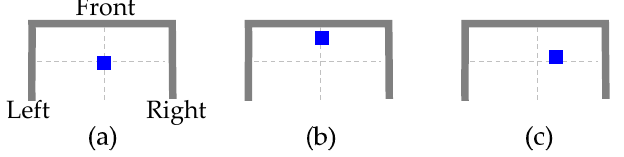
Figure 6. Locations of the communication center in an n -shaped layout.